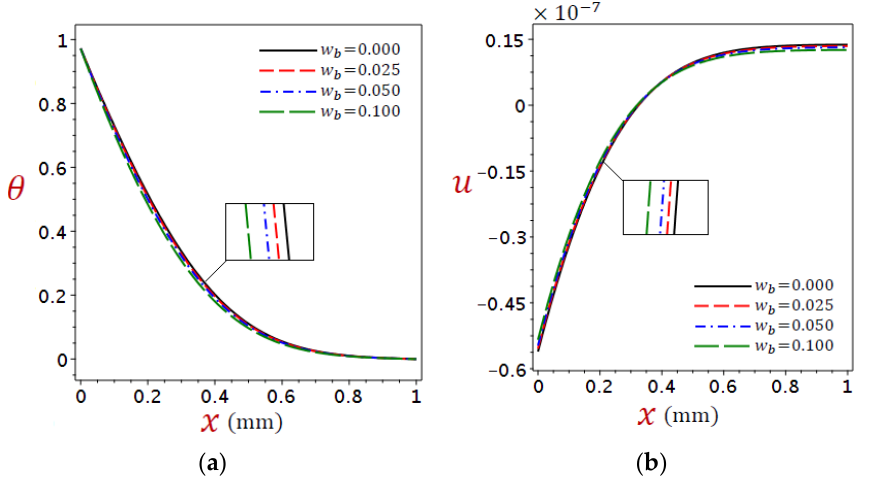
Figure 13. Distributions of ( a ) temperature ( θ ) and ( b ) displacement ( u ) across the skin tissue using numerous values of blood perfusion rate ( w b ) due to the refined DPL model.